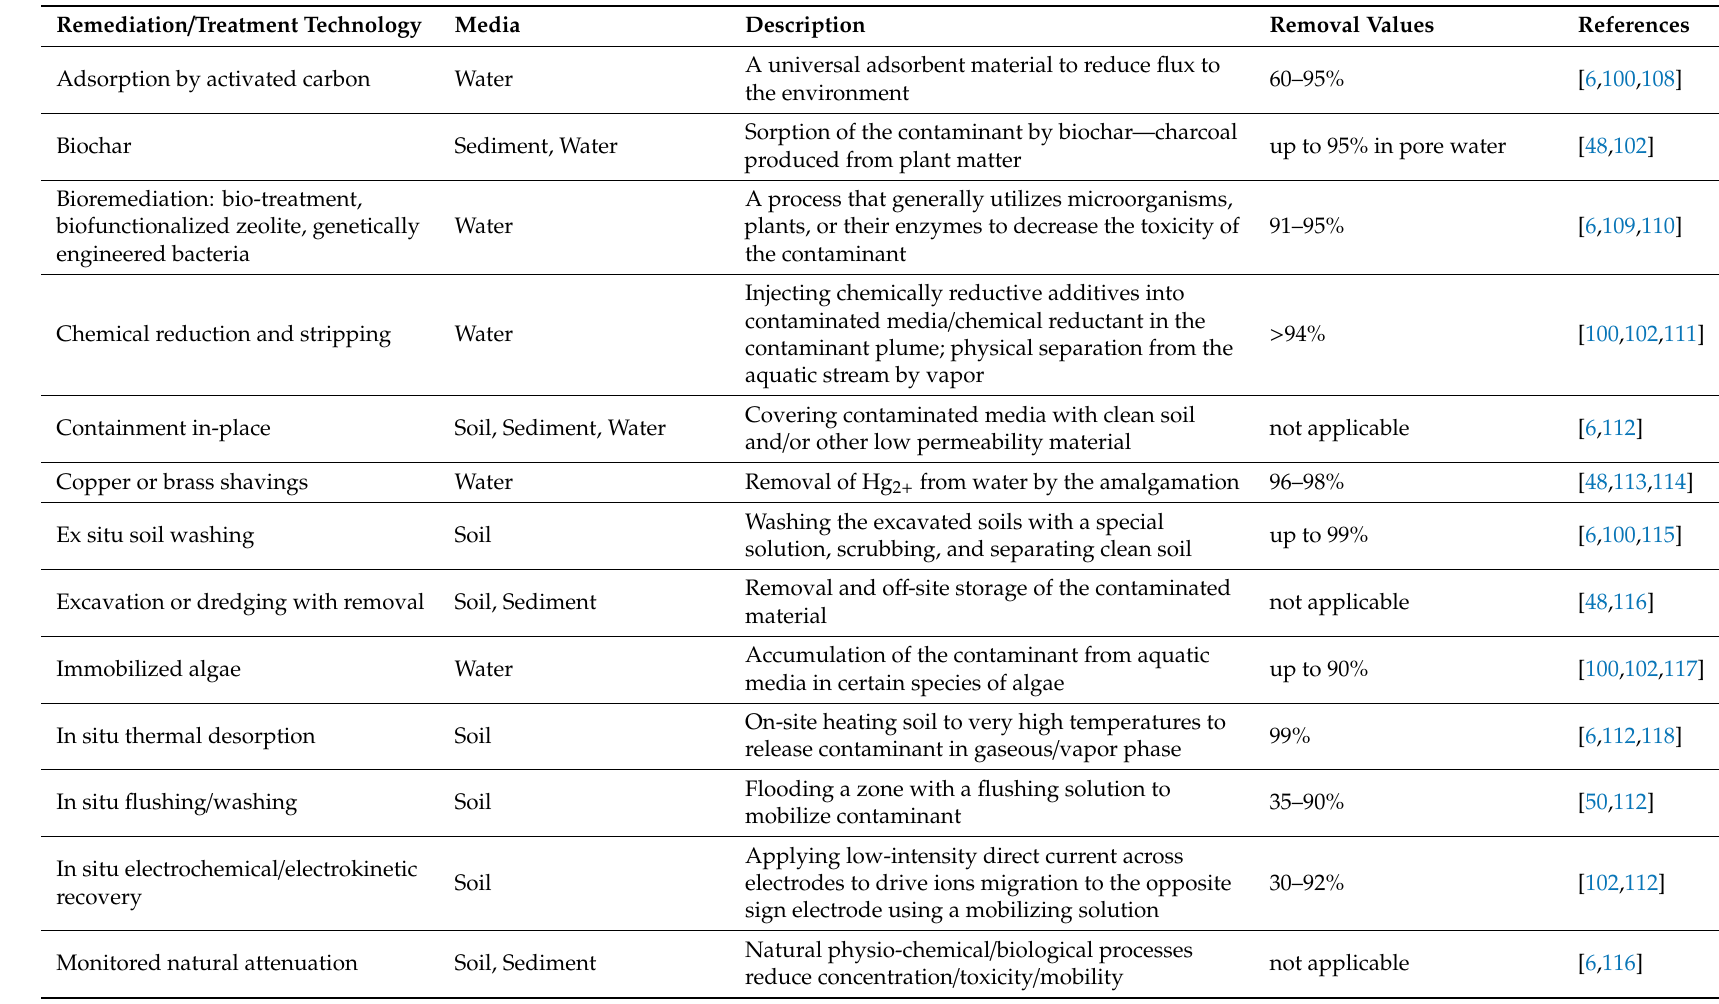
Table 5. Selected reviewed remediation